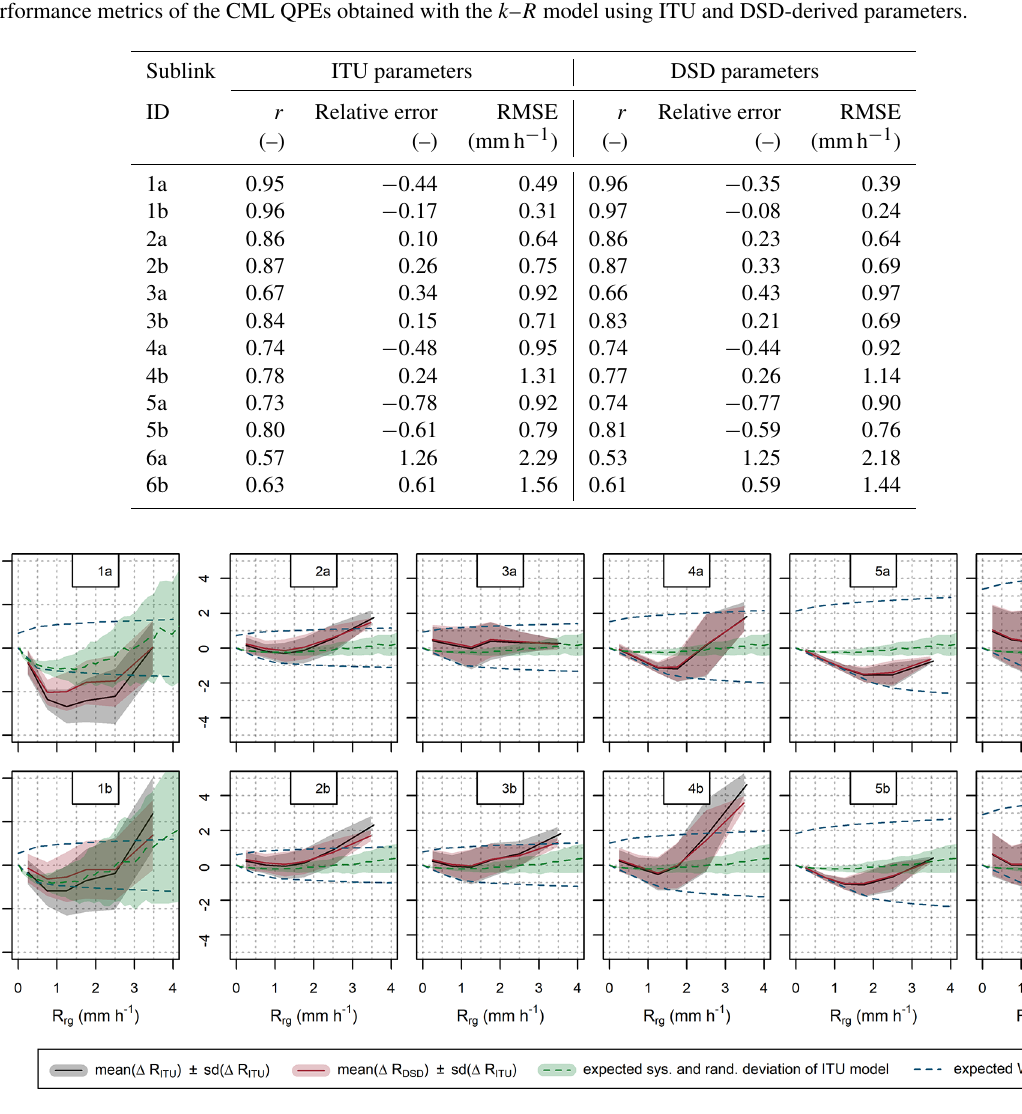
Figure 10. Deviations of CML QPEs when using the k – R model with ITU parameters and DSD-derived parameters for stratiform rainfalls. Expected deviations due to DSD and deficits in the constant WAA model are also shown. Note the different scale of y axis for the long (1a, b) and the short (2–6a, b)